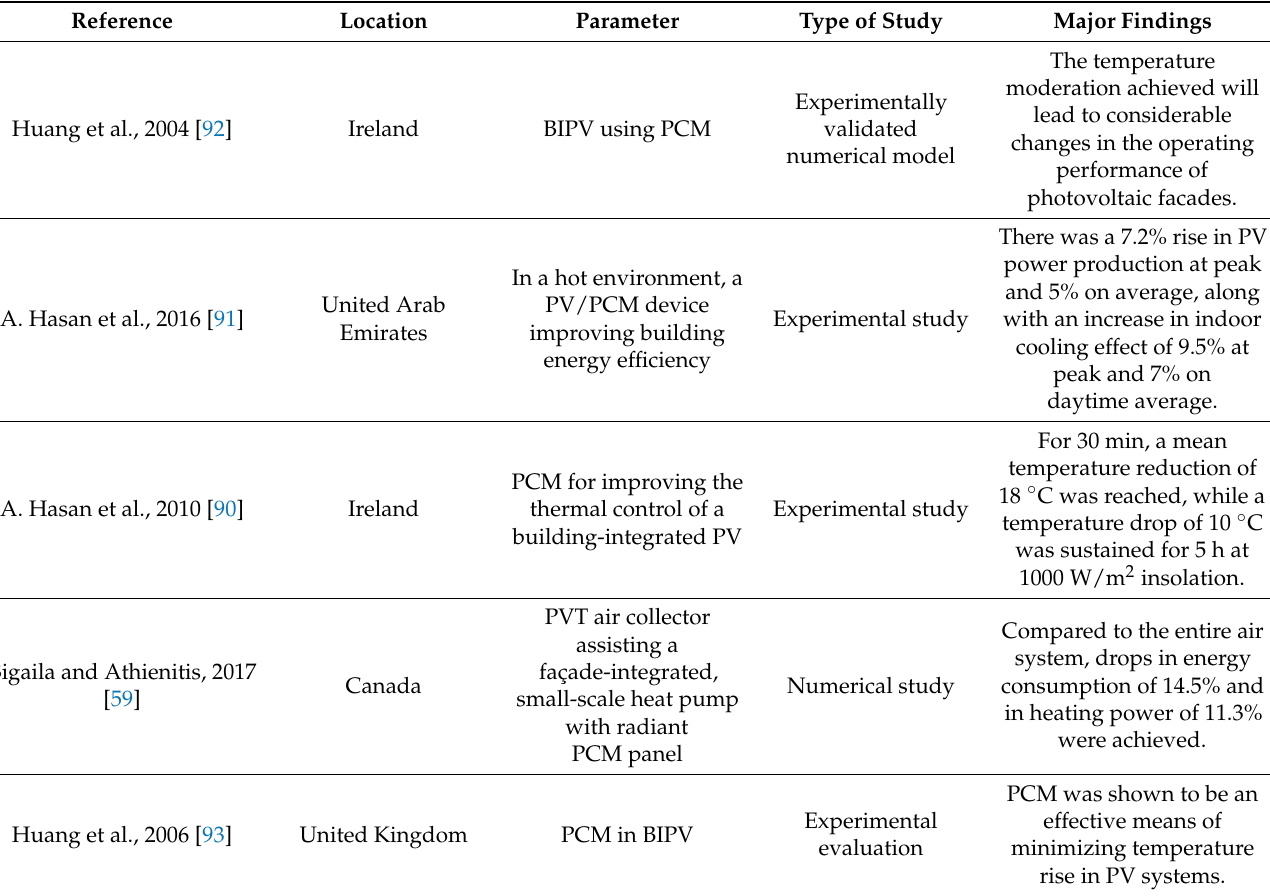
Table 4. Summary of the studies reviewed herein for building photovoltaic system cooling by using